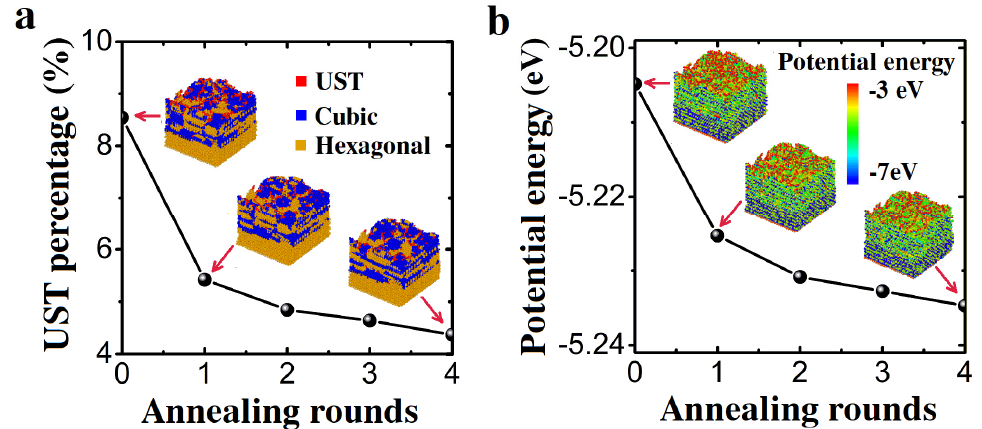
Figure 7. ( a ) The percentage of UST atoms and the snapshots of the lattice structures (insets) of sample B after different rounds of annealing at a temperature of 4000 K. ( b ) The average potential energy and the potential energy distribution (insets) of sample B after different rounds of annealing.